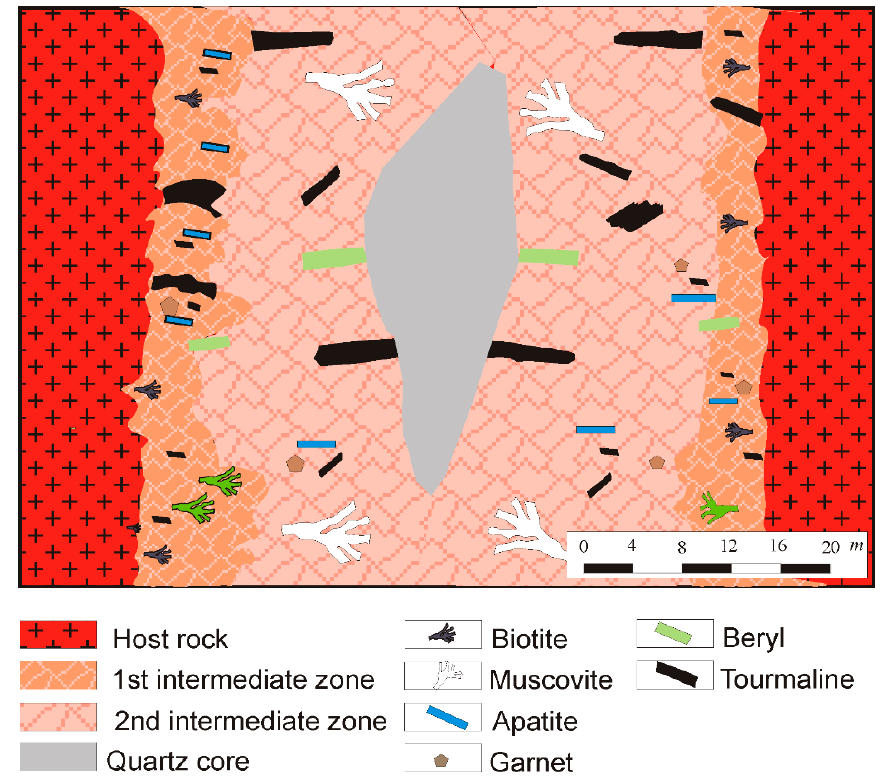
Figure 4. Conceptual scheme (not to scale) with the various pegmatite units in type-I pegmatites, showing the distribution of the most significant minerals.